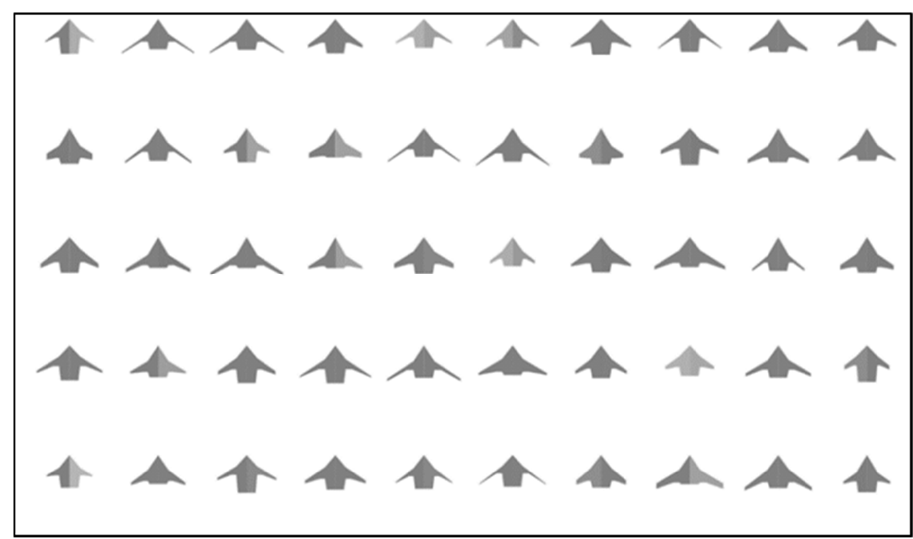
Figure 3. Extract of shapes considered for a DoE for a BWB design.